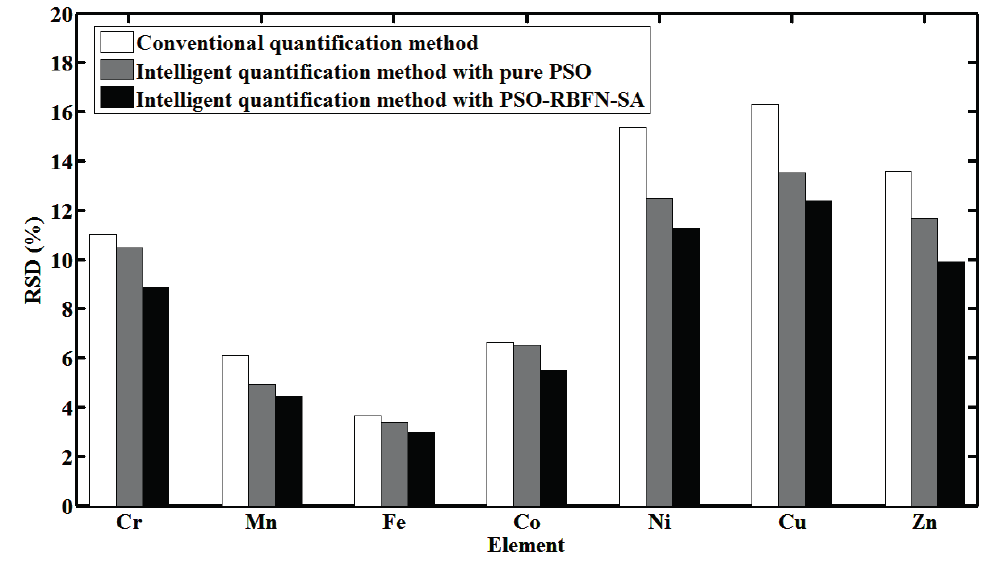
Figure 9. Comparison of conventional and proposed quantification methods in accuracy of measurement